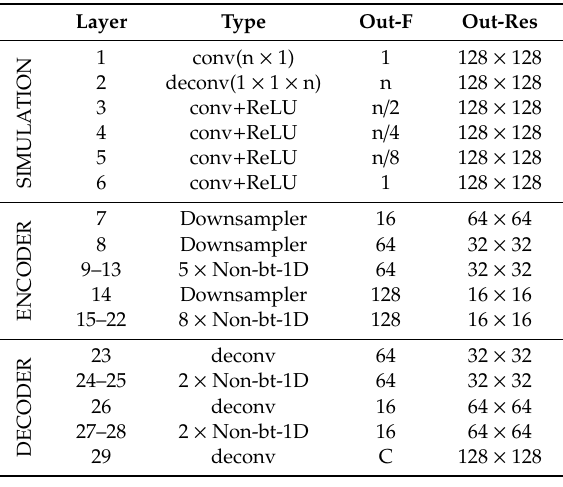
Table 1. Network